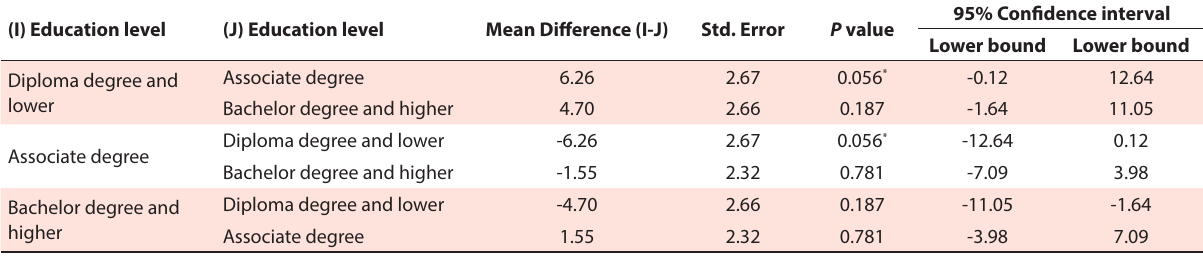
Table 2. Comparison the level of personnel education with their attitude (I) Education